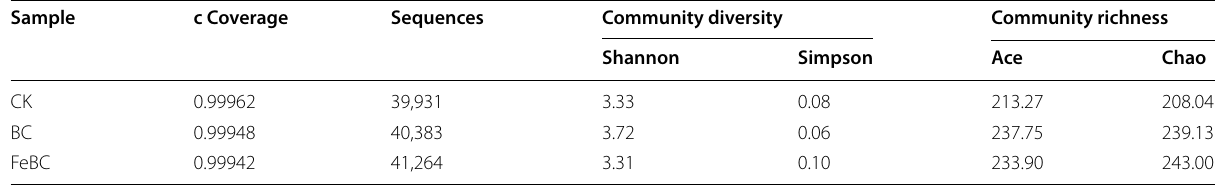
Table 2 The coverage rate, sequence number, microbial community diversity and richness indices of the different anammox systems acquired by high-throughput sequencing